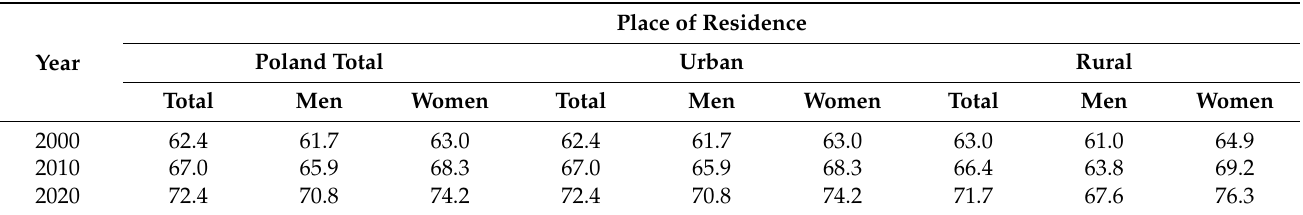
Table 1. Mean age of people who died due to skin melanoma by gender and place of residence in Poland in 2000, 2010 and 2020.